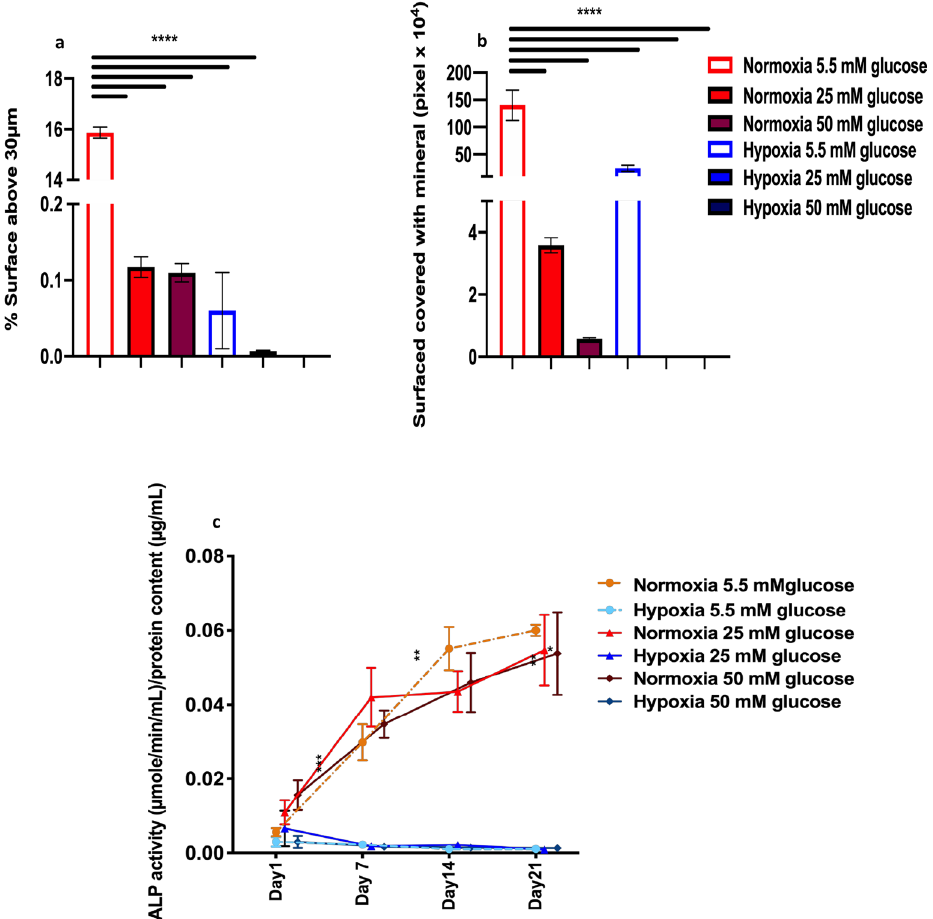
Figure 2. Inhibition of bone nodule formation in hypoxia and hyperglycaemia quantified by ( a ) interferometry (area above 30 µm) and ( b ) image analysis of Alizarin Red staining (total area). Nodules cultured in normoxia normal (5.5 mM) glucose covered a substantially larger area ( a and b total area) than both normoxia moderate (25 mM) and high (50 mM) glucose. ( c ) ALP activity per unit protein revealed that all normoxic conditions had higher ALP production than hypoxic conditions. Error bars represent the SD from the mean values. *P ≤ 0.05; **P ≤ 0.01; ***P ≤ 0.001 (n =